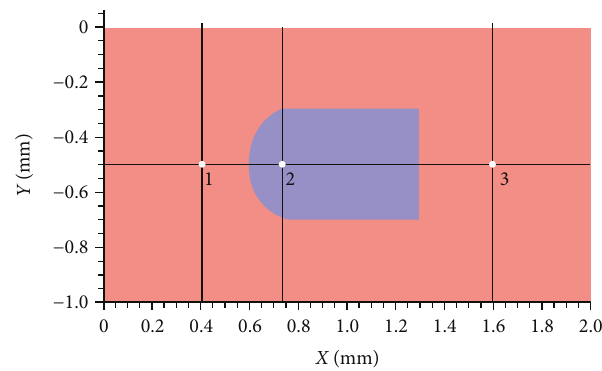
Figure 1: Computational model (the light area is the liquid phase area, and the dark area is the gas phase